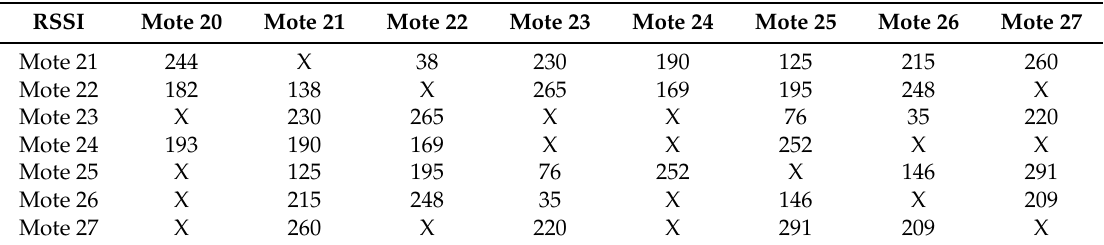
Table 1. RSSI values of the WSN at the CAEND institute.